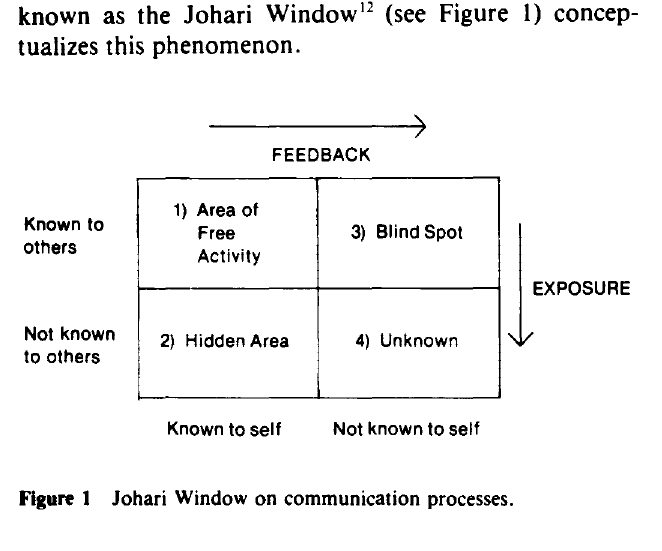
Figure 1 Johari Window on communication